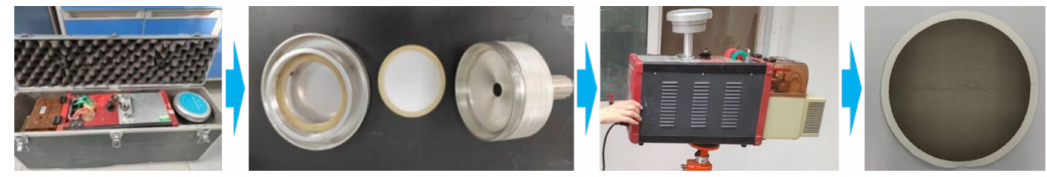
Figure 2. Sample collection method.